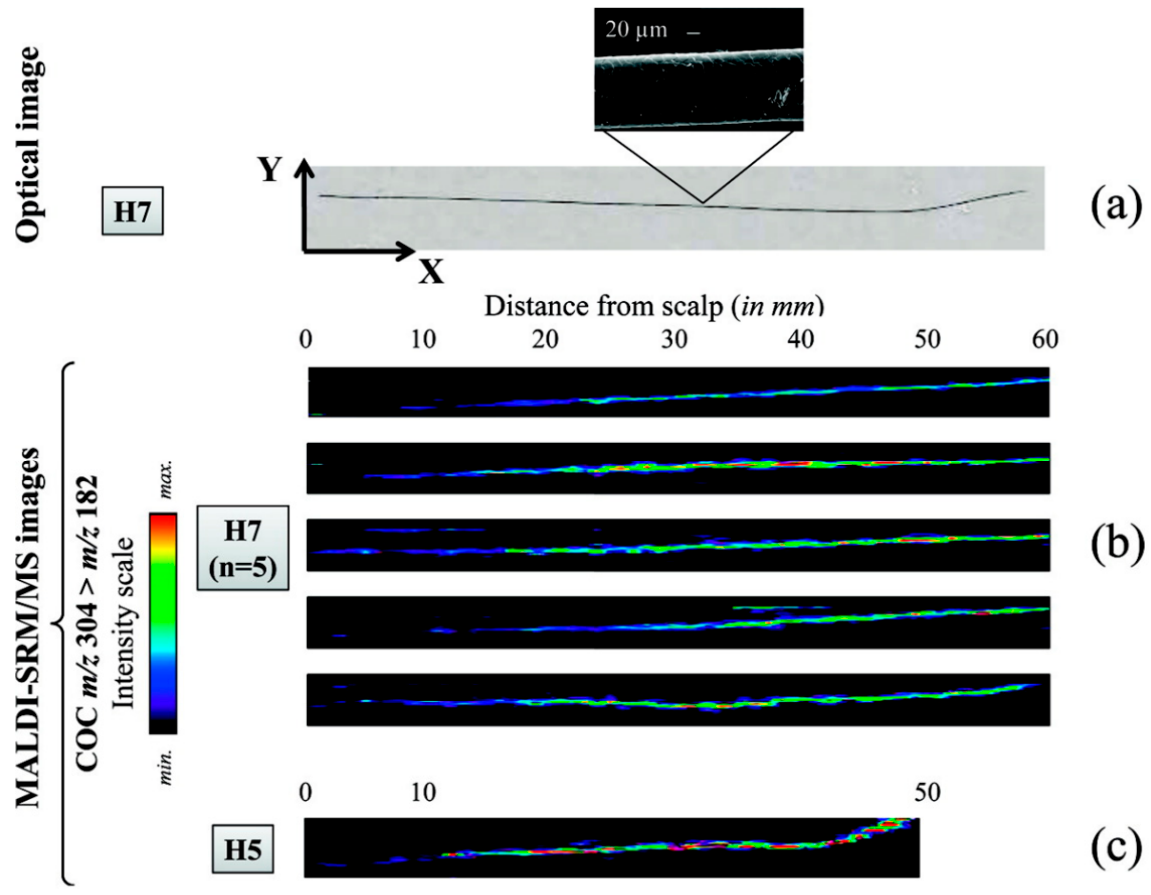
Figure 8. Relative quantification of the record of cocaine consumption over several months, as reflected in single intact hair samples from two different individuals (H7 and H5). The images were obtained by Porta et al. using MALDI-selected reaction monitoring/MS. ( a ) An optical image of a single hair from individual H7, attached to the stainless steel MALDI plate using double-sided adhesive foil. ( b ) Imaging of cocaine distribution in five different intact hair samples from H7, indicating that consumption was probably reduced over the last 6 months (the average growth rate of scalp hair being approximately 1 cm/month [114]). ( c ) An intact hair sample from individual H5, illustrating the lowest cocaine concentration detected (4.9 ng/mg, determined by LC-SRM/MS) within the first 10 mm of sample. Reprinted with permission from [110]. Copyright (2021) American Chemical Society.